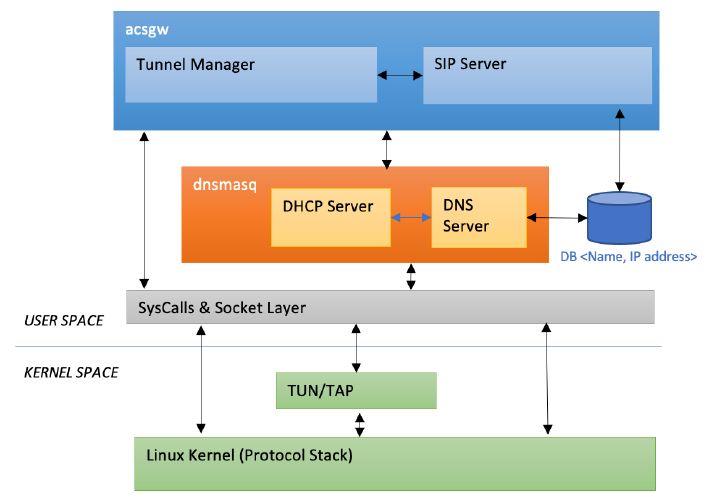
Figure 9. ACS GW simulator software architecture